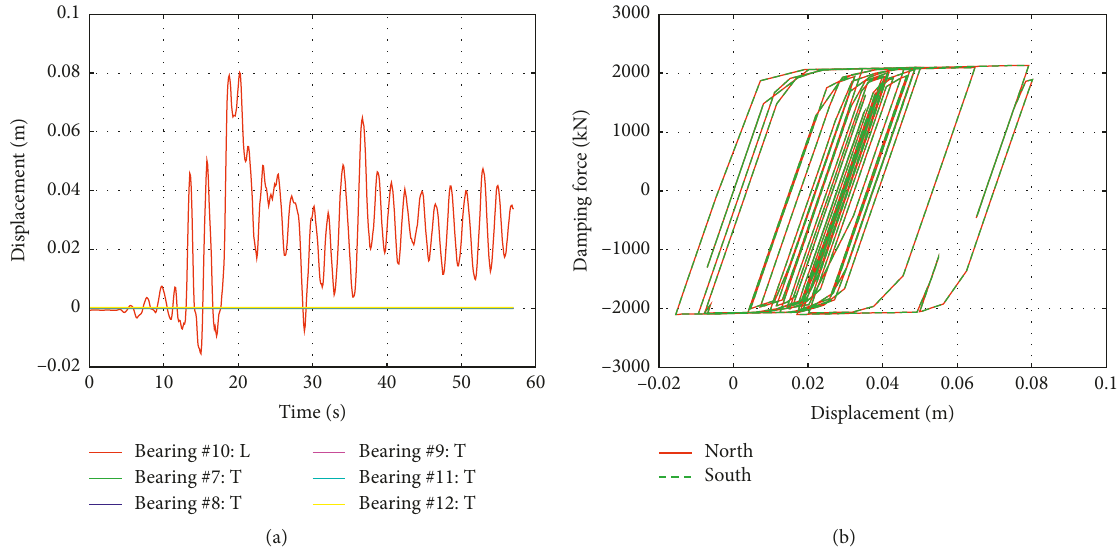
Figure 15: Longitudinal earthquake response of the bearing. (a) Bearings #7 ∼ 12 (L: longitudinal; T: transverse). (b) Force-displacement hysteretic curves of the